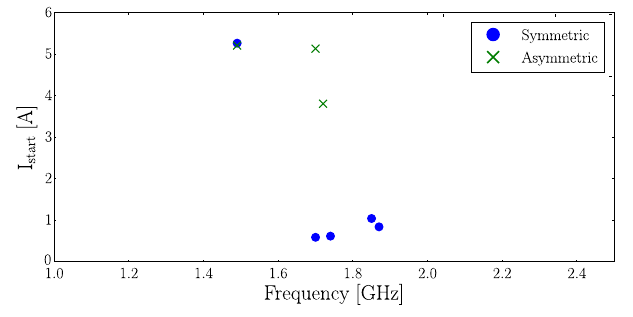
FIG. 15. Comparison of the start currents for symmetric and asymmetric cavities is shown using T